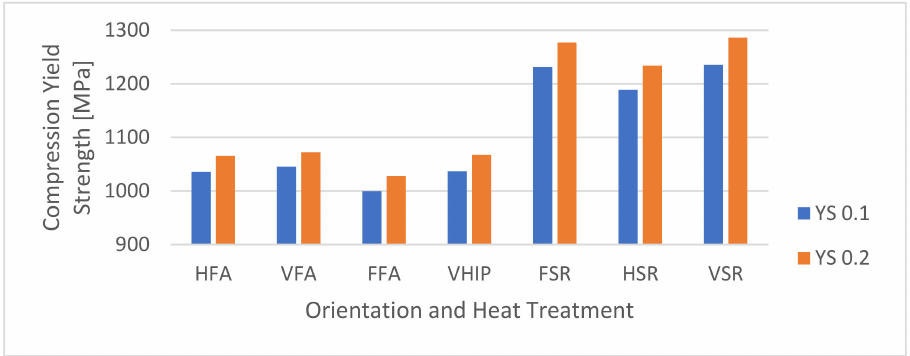
Figure 6. Compression yield strengths for 0.1% and 0.2% plastic deformation for different heat treatments and orientations.